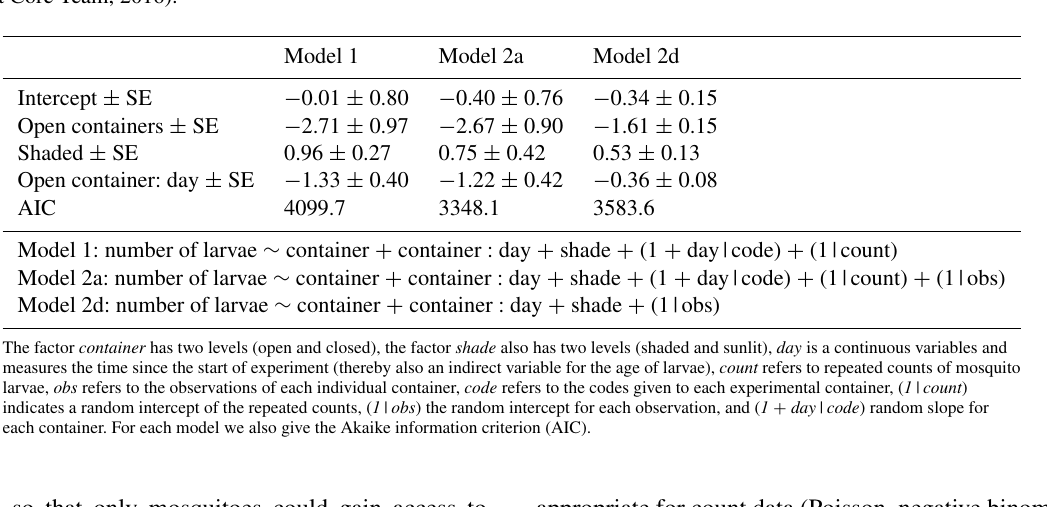
Table 2. Summary of model estimates ( ± standard errors (SE)). We also give the equations for the three models using the formalism of R (R Development Core Team,